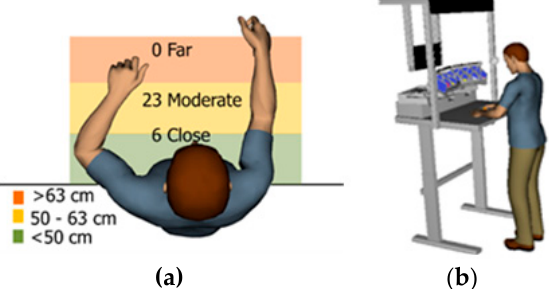
Figure 11. ( a ) Distribution of forward reaches per work cycle on smart assembly workstation; ( b ) CAD model of a smart workstation with an avatar in a virtual environment.